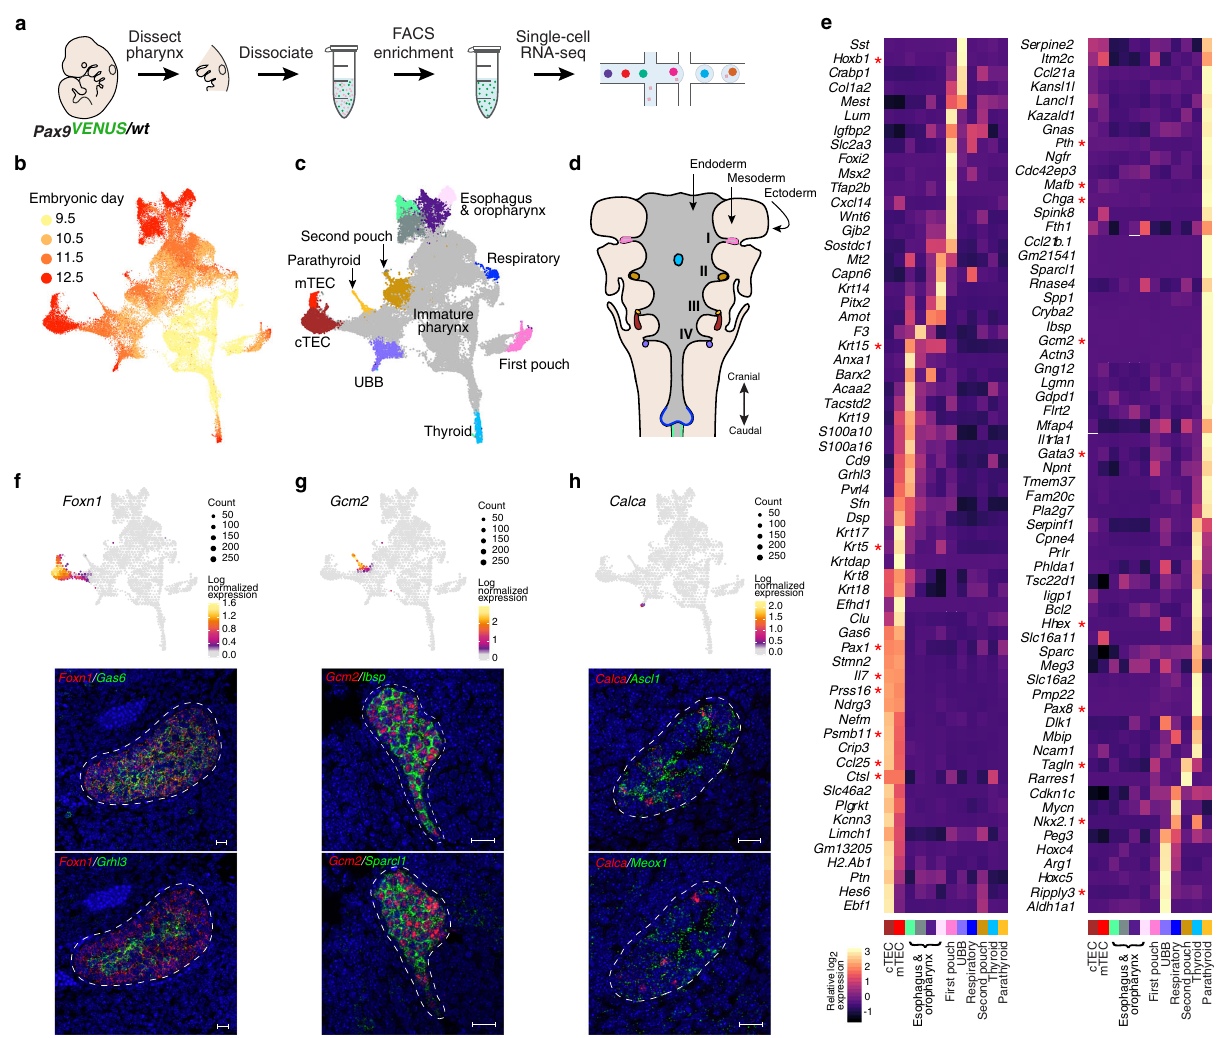
Fig. 1 Single-cell transcriptomic map of developing mouse pharyngeal endoderm from pouch formation to early organogenesis. a Experimental work fl ow schematic. Pax9 VENUS embryos were harvested at E9.5 ( n = 2), E10.5 ( n = 3), E11.5 ( n = 3), and E12.5 ( n = 2), and the pharyngeal region was dissected. Tissue samples were dissociated into a single-cell solution and then pharyngeal endoderm cells were FACS puri fi ed based on co-expression of VENUS and Epcam. Single-cell transcriptomes were captured and barcoded using Chromium Single-cell 3 ′ Reagents. b , c UMAP visualization of pharyngeal endoderm transcriptomic time-course dataset ( n = 54,044 cells) colored by embryonic day ( b ) and terminal Louvain clusters corresponding to anatomical structures ( c ). Each dot represents a single-cell in the global transcriptomic space. mTEC medullary thymic epithelial cells, cTEC cortical thymic epithelial cells, UBB ultimobranchial body. d Diagram of pharyngeal endoderm with pharyngeal pouches I – IV indicated. Organ colors correspond to cluster colors in ( c ). e Heatmap displaying differentially expressed marker genes by terminal clusters. Row-standardized heatmap of data-driven terminal cluster marker genes. Genes displayed represent a log2-fold-change cutoff of >1.5 and a p -value of <0.01. f – h UMAP visualization of expression of select tissue-speci fi c marker genes with corresponding RNAscope data. Cells are binned by UMAP coordinate with size proportional to the number of cells and color signifying average log2-normalized expression. Data-driven and known transcripts of the thymus (data-driven: Grhl3 , Gas6 ; known: Foxn1 ; n = 3) ( f ), parathyroid (data-driven: Ibsp, Sparcl1 ; known: Gcm2 ; n = 3) ( g ), and ultimobranchial body (data-driven: Ascl1, Meox1 ; known: Calca ; n = 2) ( h ) lineages were visualized using RNAscope in situ hybridization. Scale bars represent 20 µ